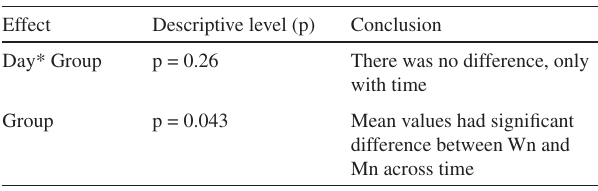
Table 6 - Repeated measures ANOVA for IL-6, adjusted for age and with log